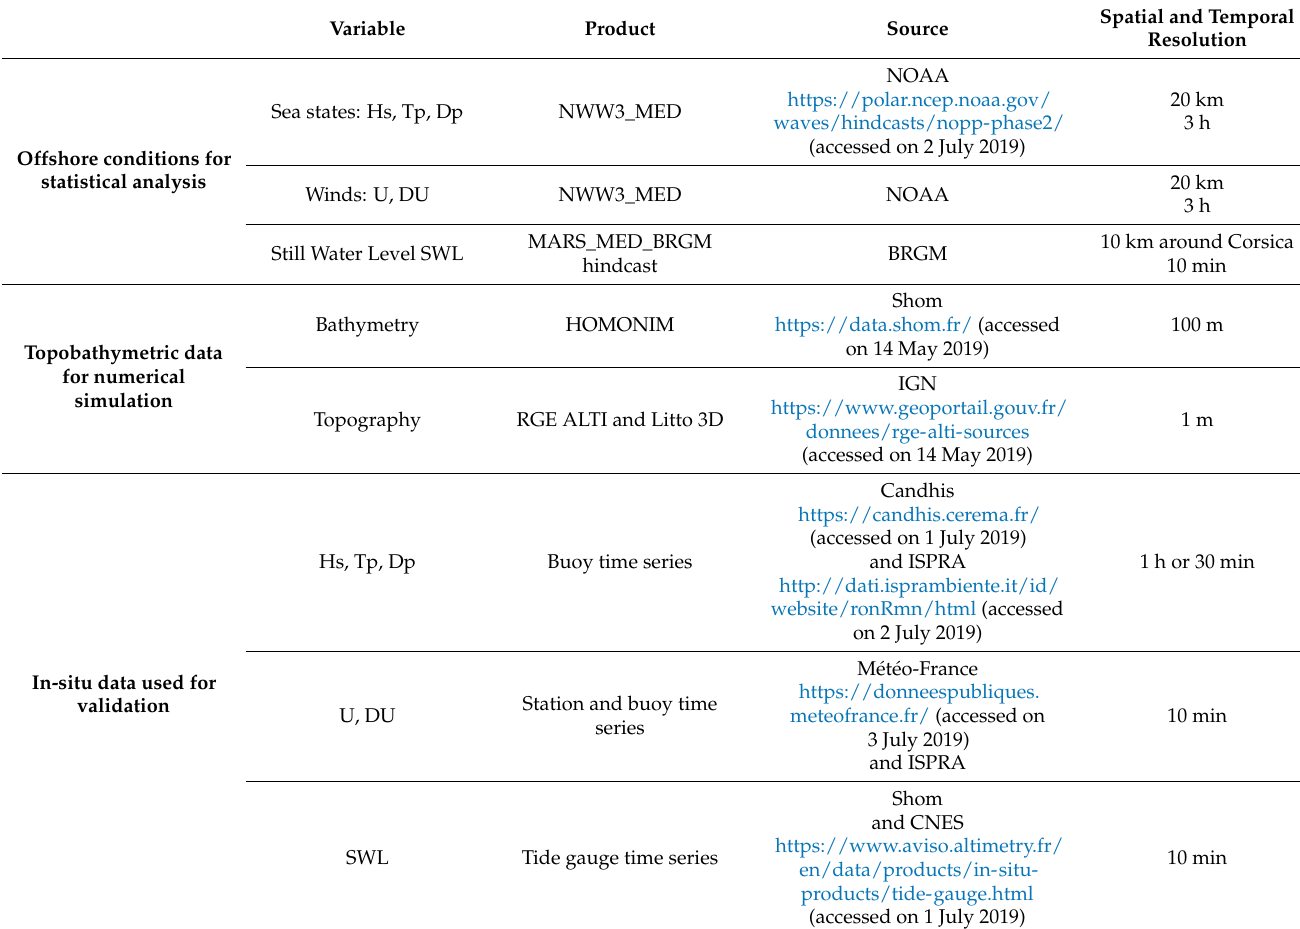
Table 1. Data used in the study, spatial resolution, temporal resolution, and sources. Variable Product Source